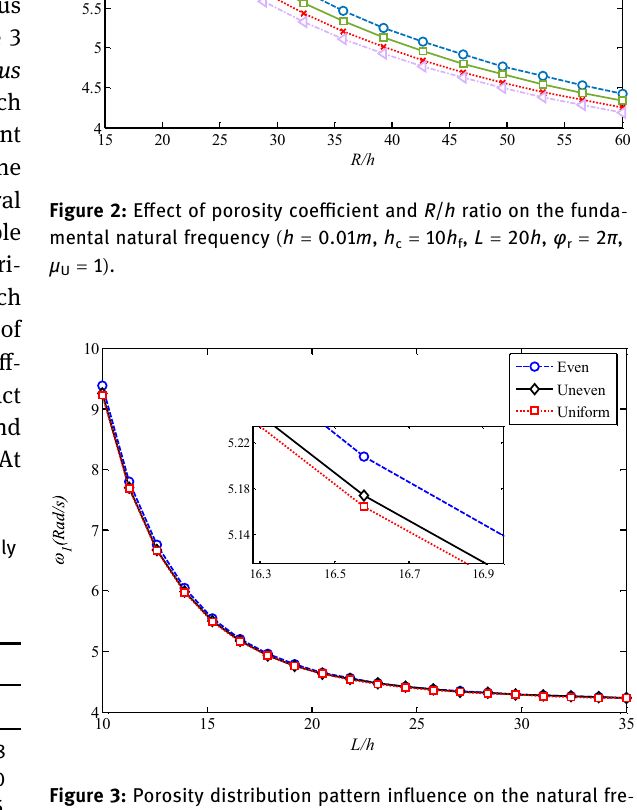
Figure 3: Porosity distribution pattern in fl uence on the natural fre - quencies of the shell versus its aspect ratio ( h = 0.01 m , h c = 10 h f , L = 50 h , φ = 2 π , μ = 1 ) . r U